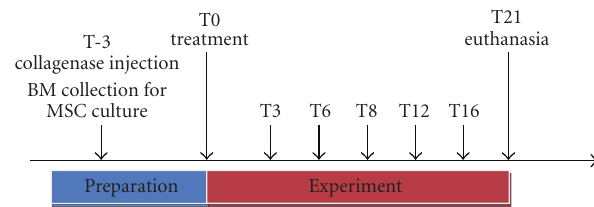
Figure 1: Time course description of the study performed over a period of 24 weeks (T-3-T21); US data were recorded immediately prior to collagenase injection to induce tendon injury, recorded as T-3, then 3 weeks later, just prior to injection of either cBMSC or BMMNCS suspension, fibrin glue, or placebo ( = saline) into the tendon lesion (T0), and again at 3, 6, 8, 12, 16, 18, and 21 weeks (T3- T21) following tendon treatment. At T21, animals were euthanized and the SDFTs of all four limbs were harvested and processed for histology and immunohistochemistry